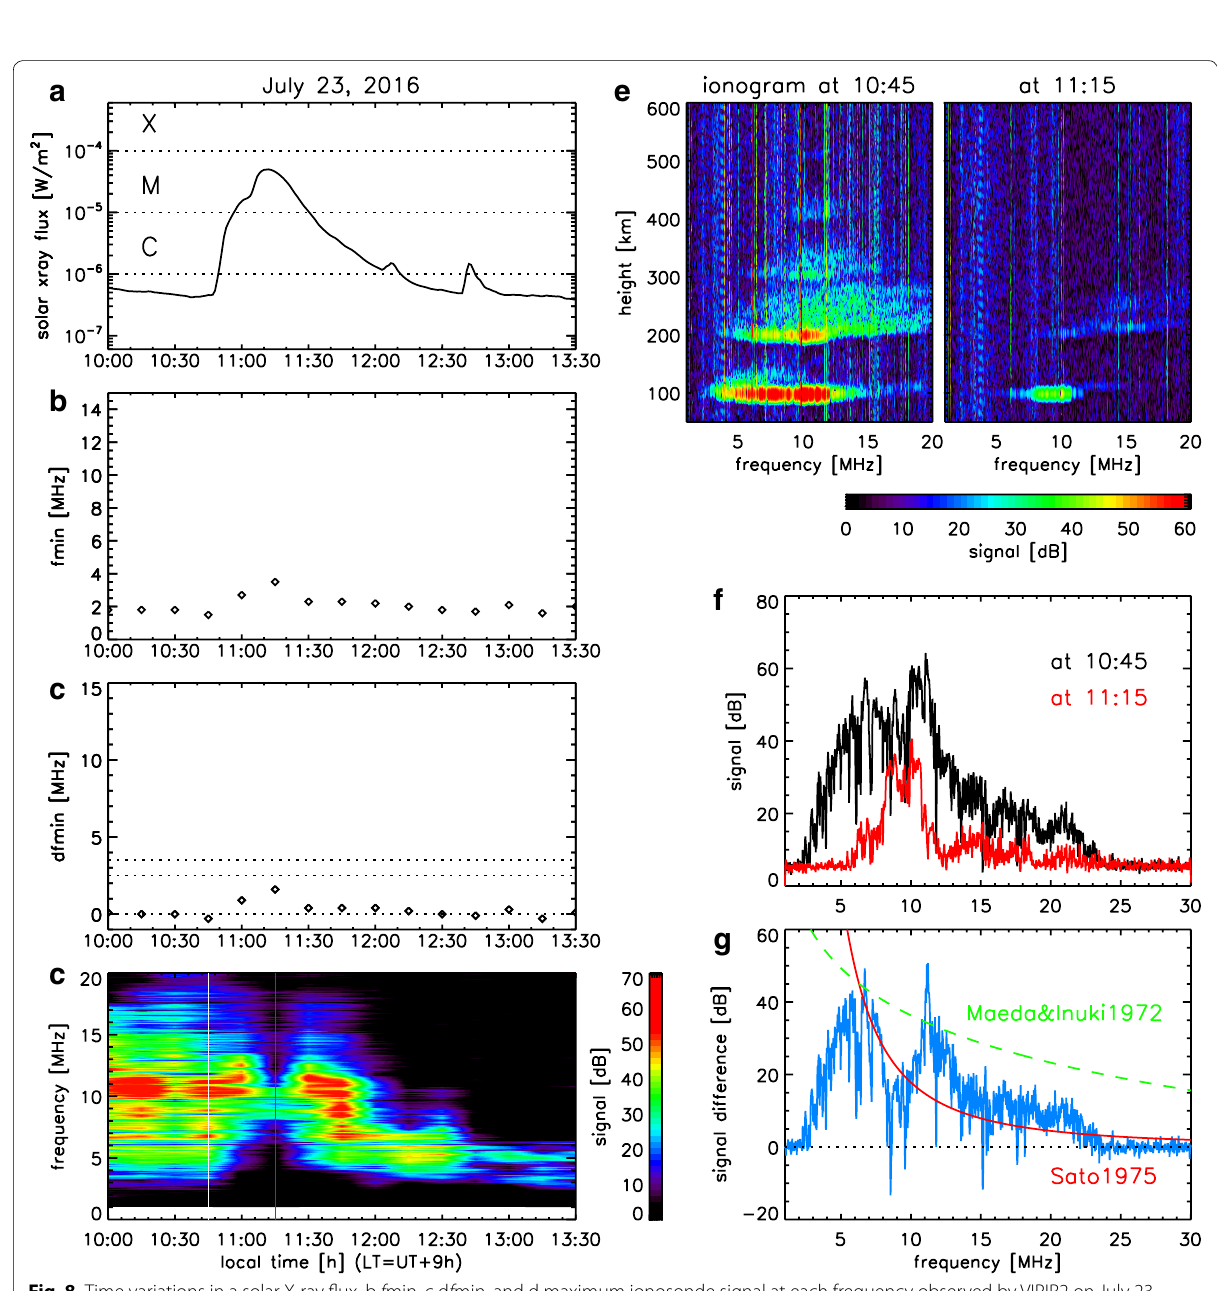
Fig. 8 Time variations in a solar X-ray flux, b f min, c d f min, and d maximum ionosonde signal at each frequency observed by VIPIR2 on July 23, 2016, e VIPIR2 ionograms at LT( UT 9 h) 10:45 (left) and 11:15 (right), f VIPIR2 signal intensities before SWF at LT 10:45 (black) and during SWF at = + 11:15 (red), and g their difference representing SWF absorption (blue), as a function of frequency. Absorption intensities estimated using Eq. (10) from Maeda and Inuki (1972) and twice Eq. (2) from Sato (1975) are shown by the green dashed and red lines, respectively, in Fig.